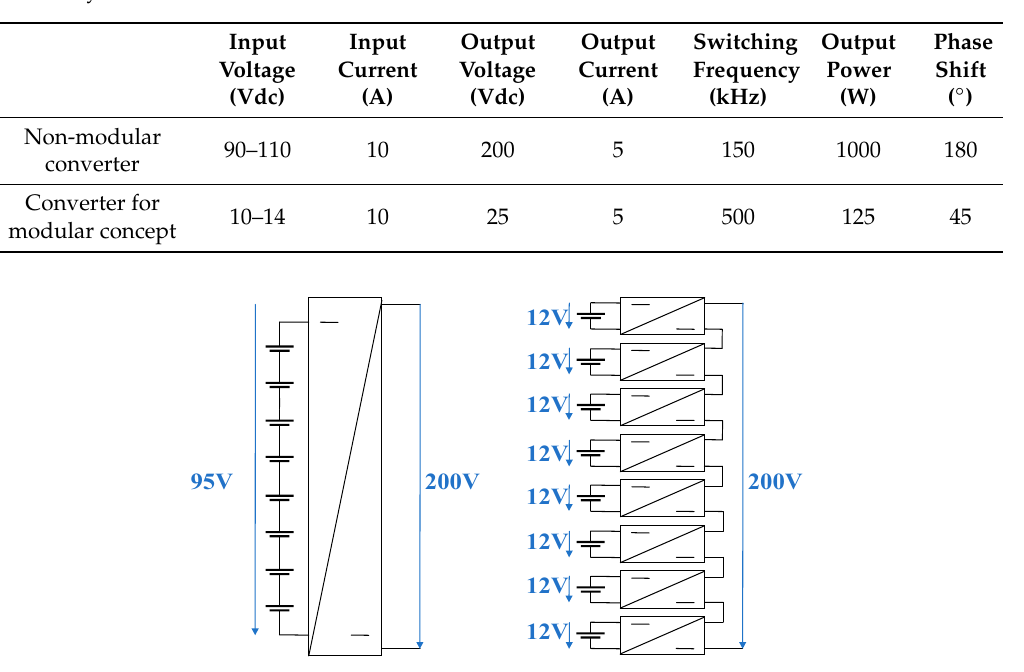
Figure 11. Block diagram of non-modular converter concept (left) and modular converter concept (right) in reduced power ratio.